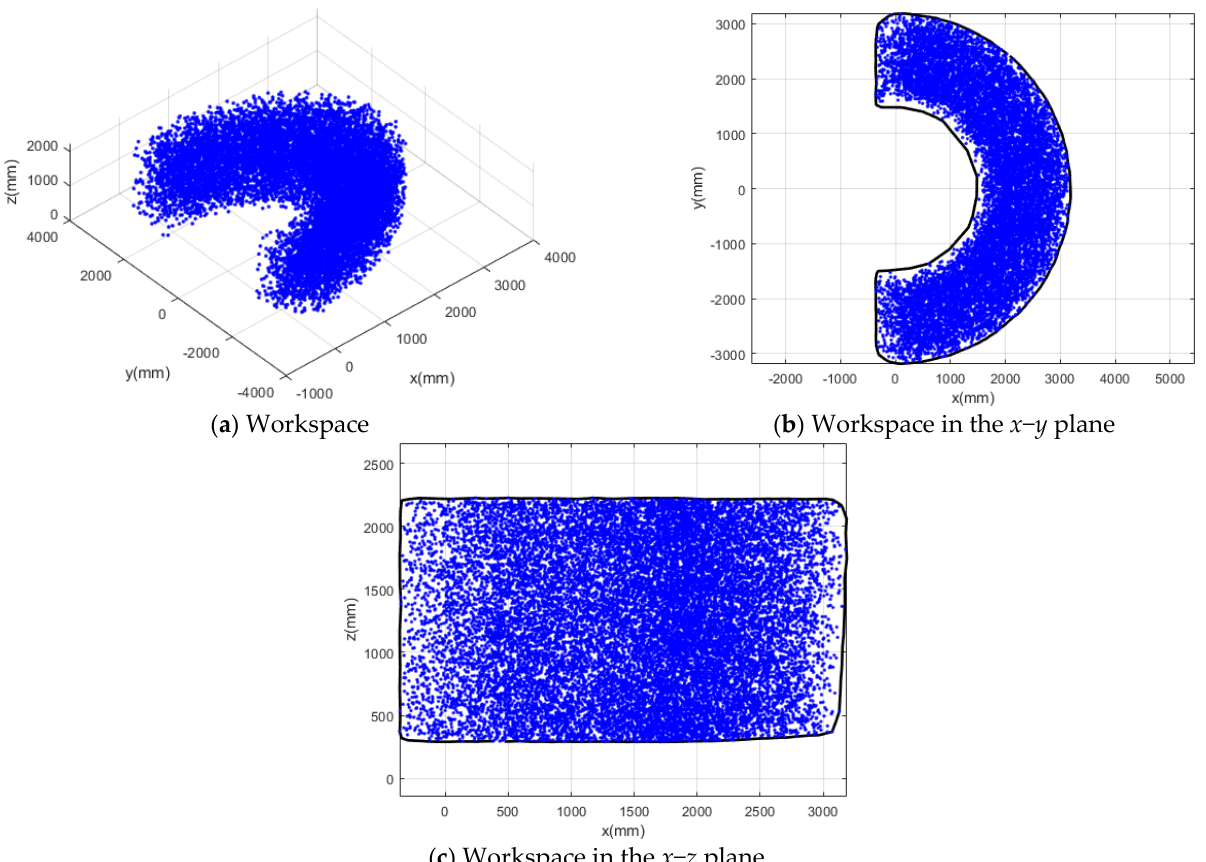
Figure 3. Banana − harvesting robot workspace: ( a ) three − dimensional workspace; ( b ) workspace in the x – y plane; ( c ) workspace in the x − z plane. Each blue point is obtained by sampling the joint space of the robot randomly and solving the forward kinematics equation. Black lines form the boundaries of the workspace.